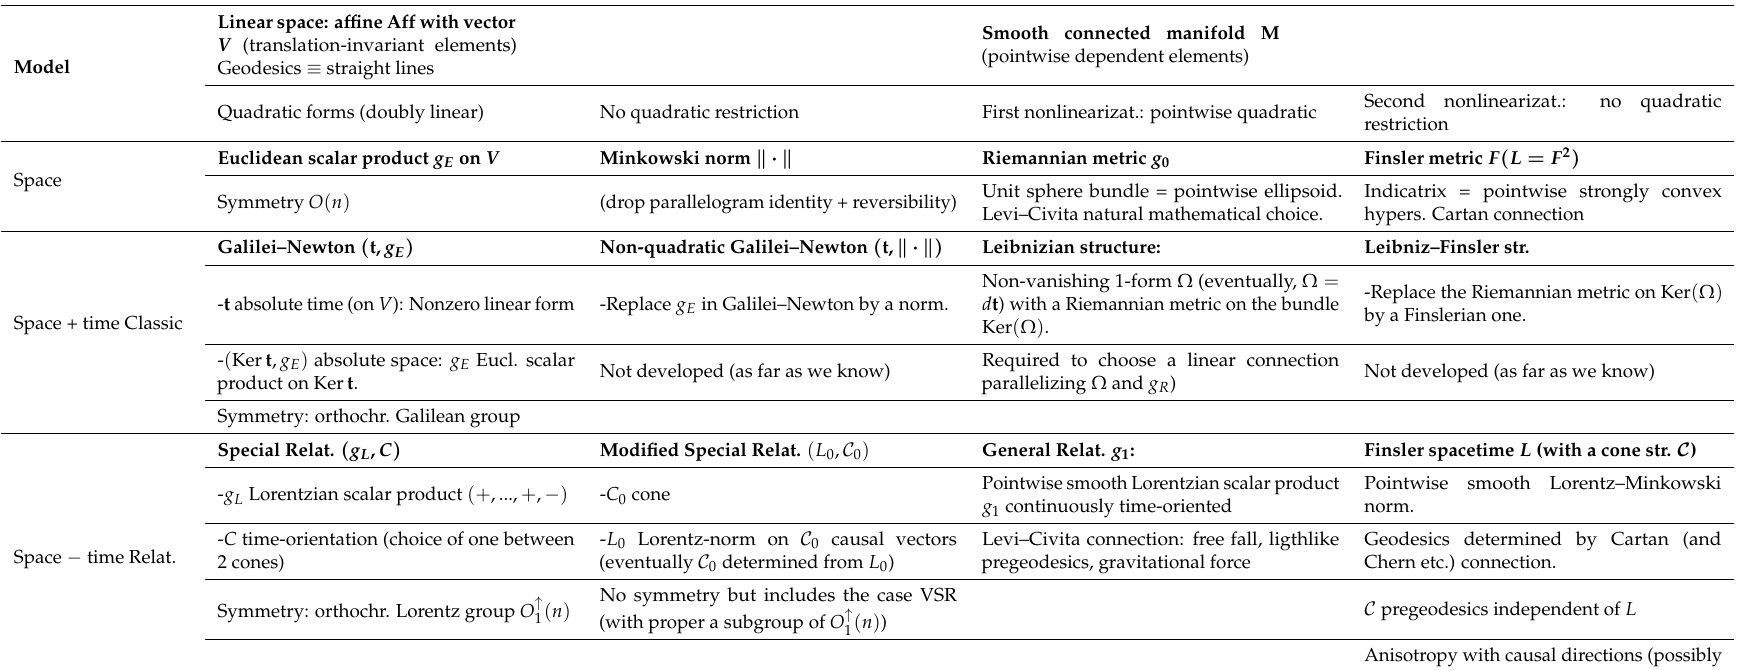
Table 1. Classical models of non-quantum space and time (linear models and their non-linearizations). For Very Special Relativity (VSR) see Section